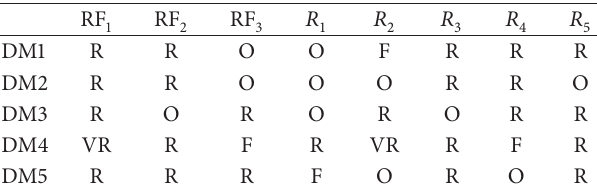
Table 3: The likelihood for risk factors and risks.